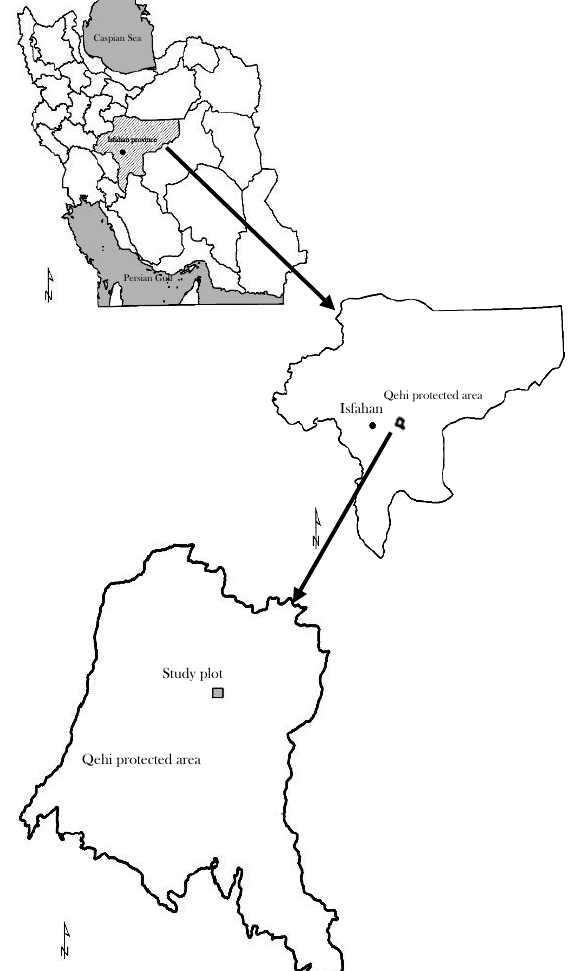
Figure 1. The study area in Isfahan province, Iran.